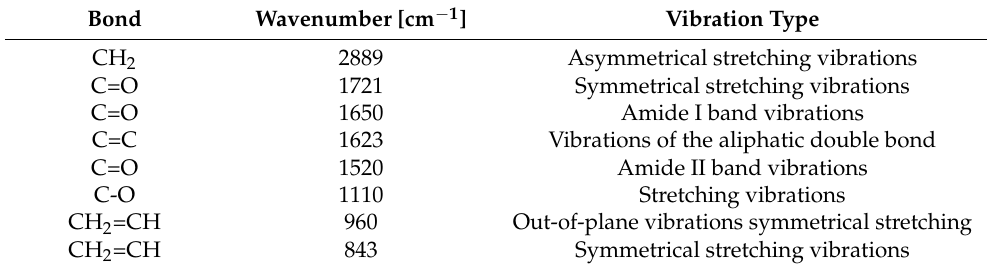
Table 1. Characteristic absorption IR vibration bands for PEG-acrylate and peptide species.